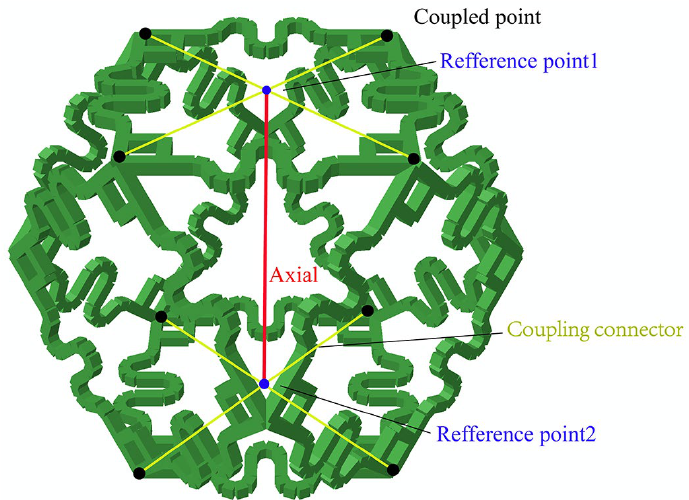
Figure 16. Schematic diagram of the active drive cell and axial unit.